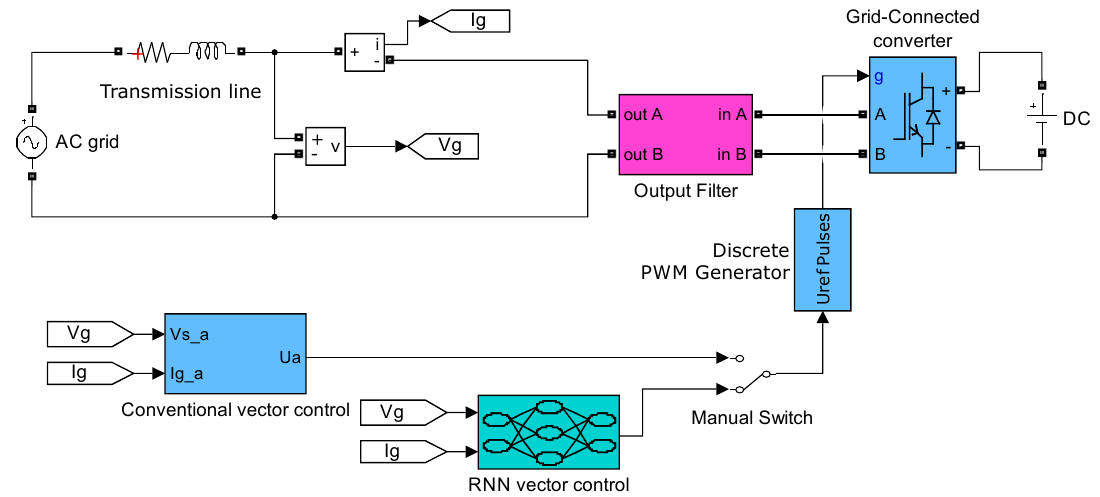
Figure 8. Simulink models of the single-phase GCC with the output filter.